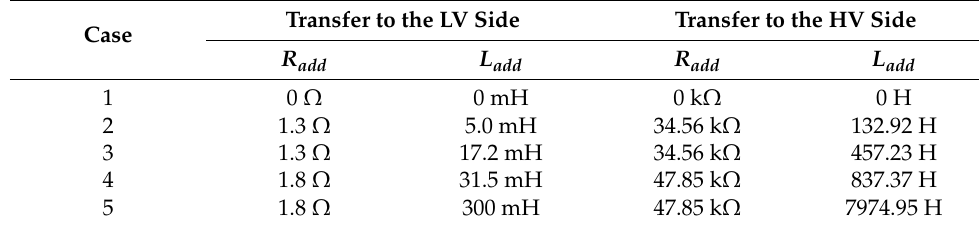
Table 2. The additional inductances and